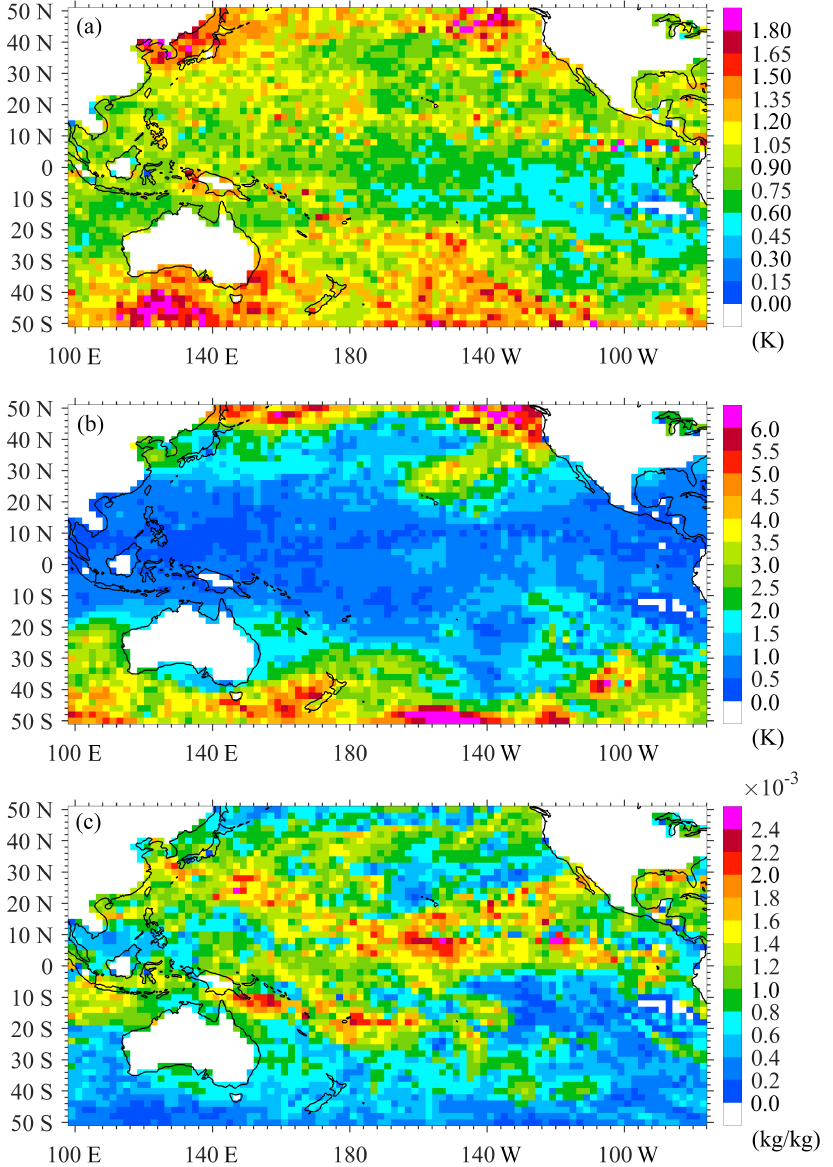
Figure 9. Spatial distribution of: ( a ) “O − B” standard deviation (unit: K) for Channel 13 (WF peaks at 600 hPa); ( b ) variability of atmospheric temperature (unit: K); and ( c ) specific humidity (unit: kg/kg) at 600 hPa of ERA-5 from 24 September to 8 October 2021. The blank boxes in the Eastern Pacific are caused by quality